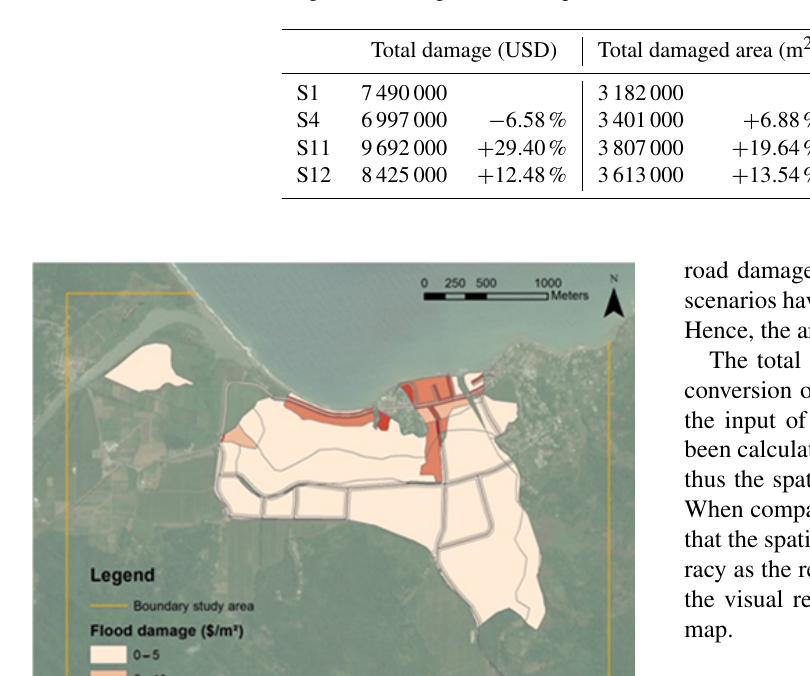
Table 8. Calculated total damage, total damaged area and spatial difference for S11 and S12 in comparison to S1.